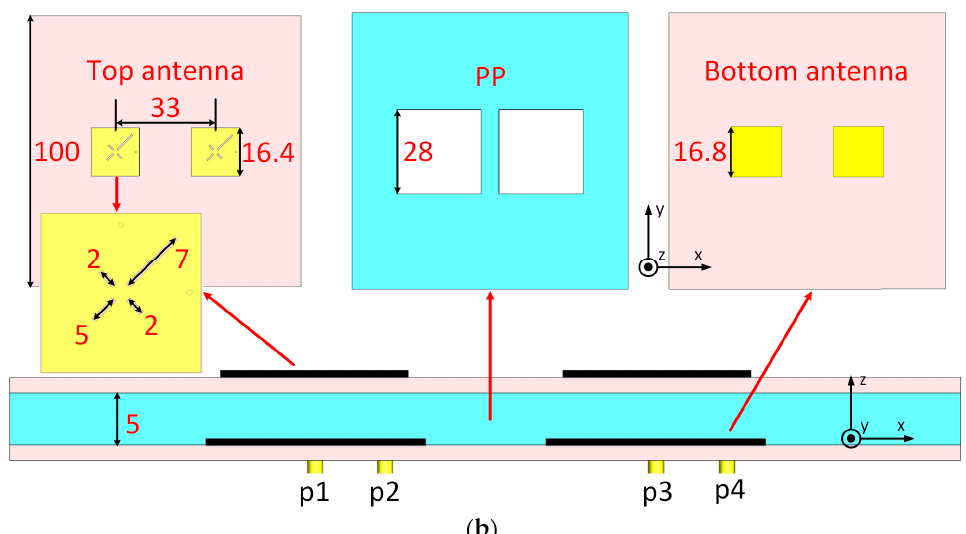
Figure 4. ( a ) Design procedure of the isolation improvement for dual-element dual-polarized antenna array with NRMS. Array 1 is the reference antenna array. In the next step, Array 2 is depicted, where a metasurface consisting of periodic cross metal rings with a period T is employed above Array 1, where the air cavities with a period 2 × T are engraved on the metasurface. ( b ) The configuration of the reference array in the design procedure. (Unit: mm).